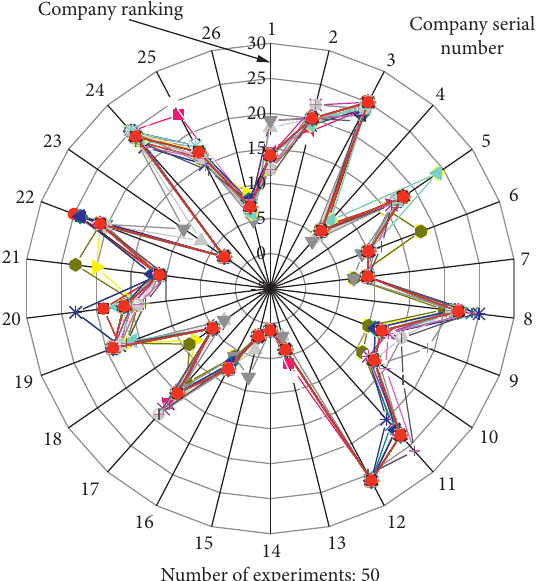
Figure 3: Weight sensitivity analysis results of the improved VIKOR method.